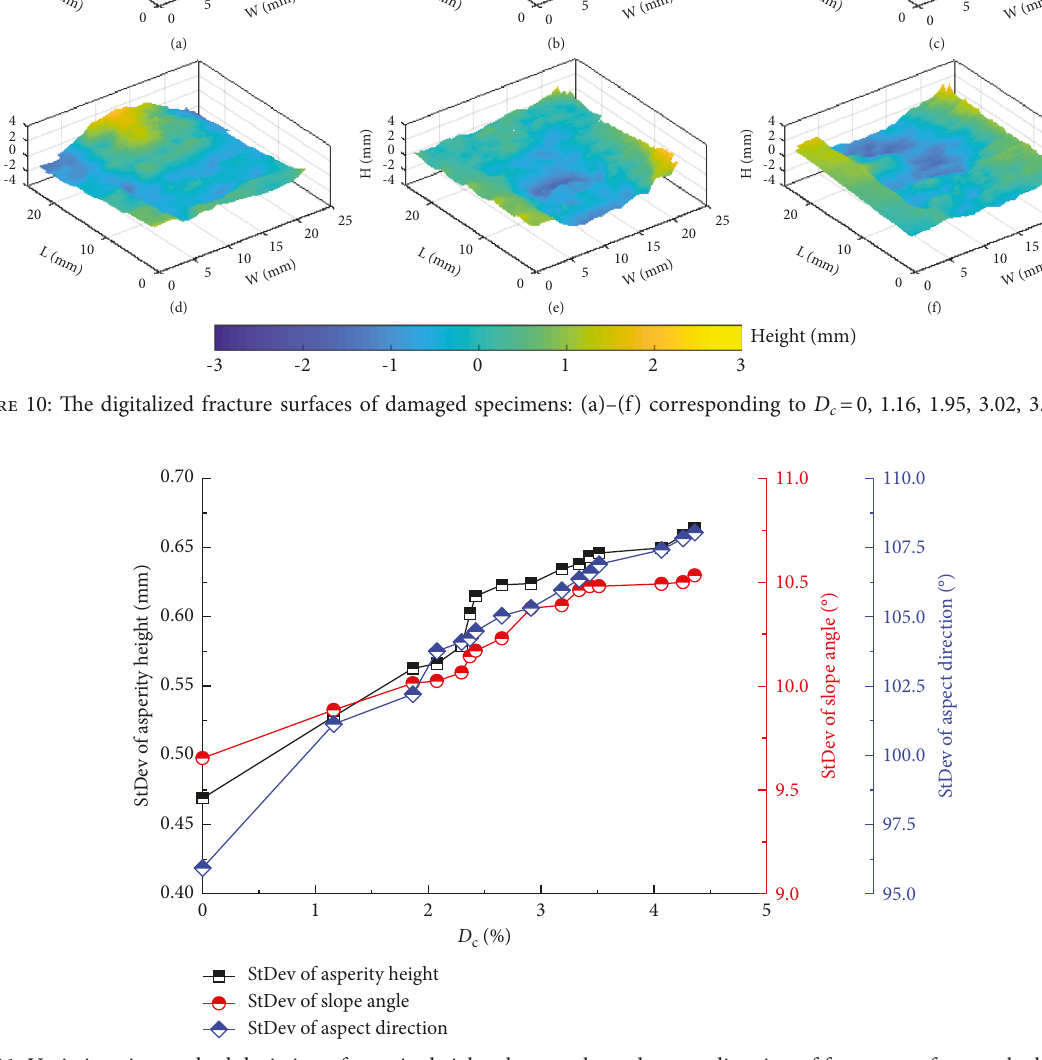
Figure 11: Variations in standard deviation of asperity height, slope angle, and aspect direction of fracture surface mesh elements versus damage variable.